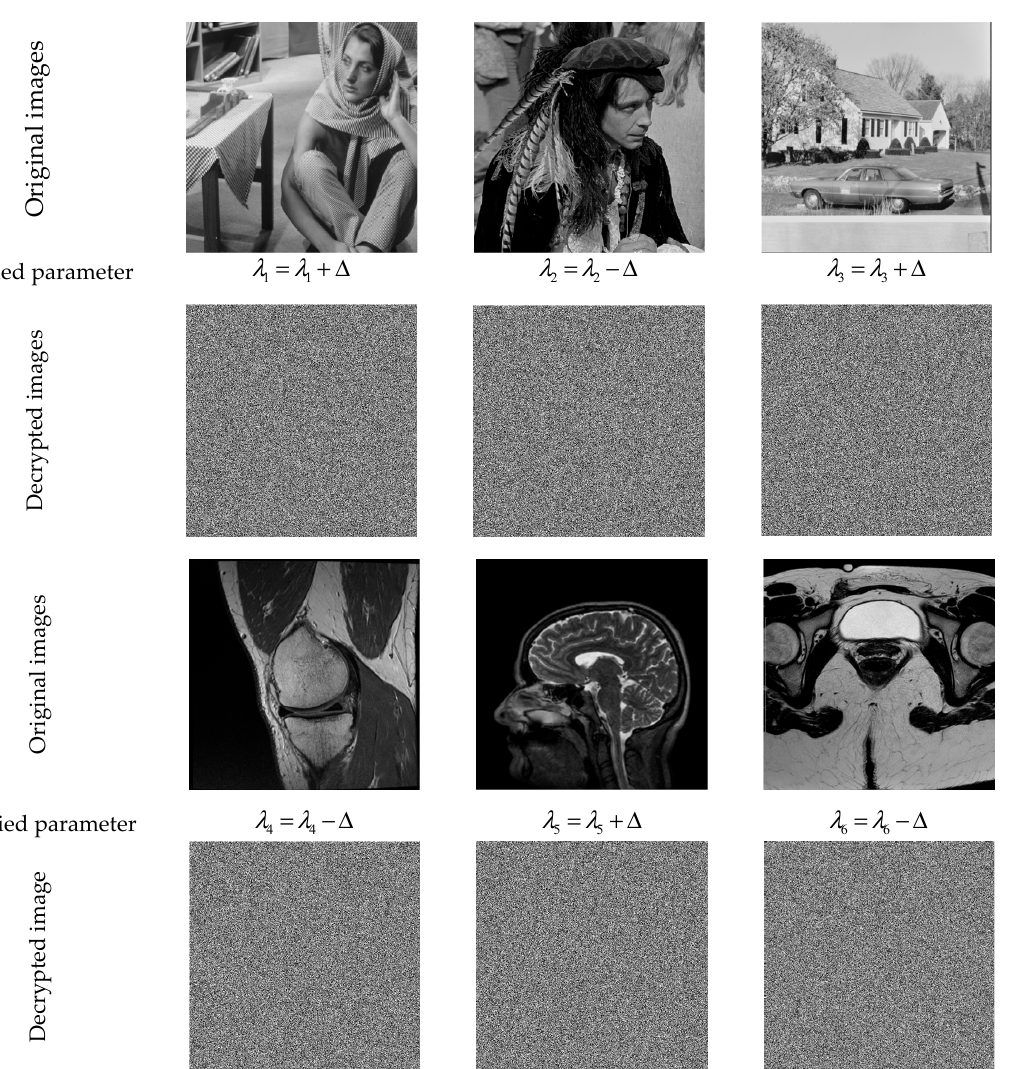
× Figure 14. Grayscale test images of size 512 512 with its encrypted versions and decrypted ones Figure 14. Grayscale test images of size 512 × 512 with its encrypted versions and decrypted ones following a minor modi fi cation of KEY parameters by 13 10 − Δ =  . following a minor modification of KEY parameters by ∓ ∆ = 10 − 13